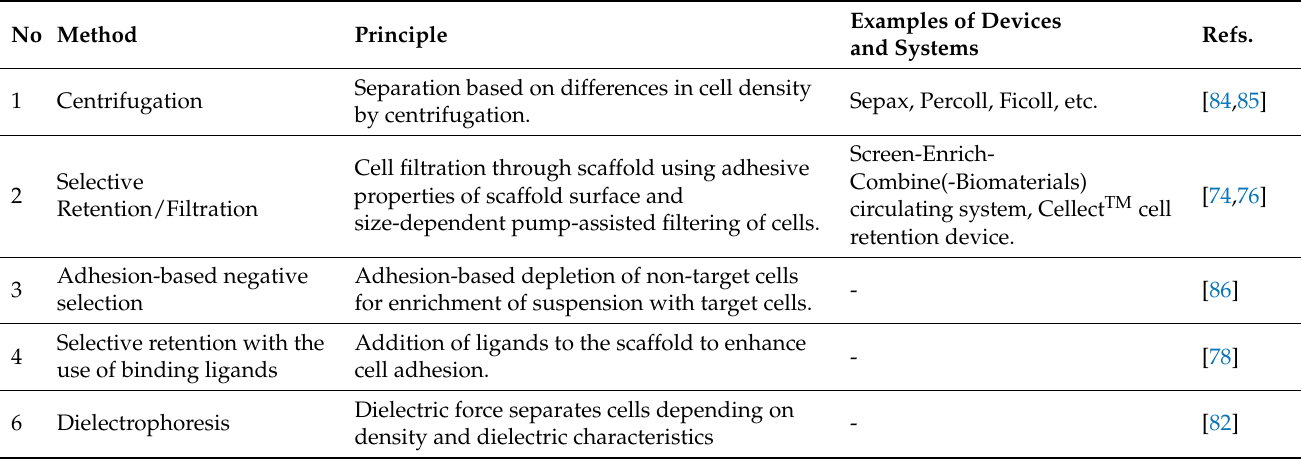
Table 1. Methods for intraoperative cell isolation for in situ tissue